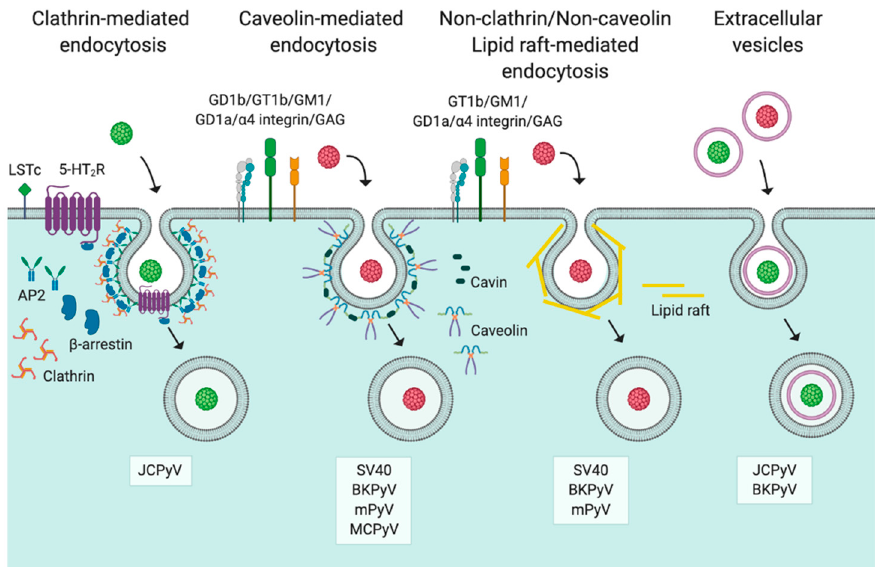
Figure 2. Entry pathways usurped by polyomaviruses. Polyomaviruses have been identified to hijack several of the currently known pathways to enter cells. JC polyomavirus (JCPyV) (green virion) is the only characterized polyomavirus to date that utilizes clathrin-mediated endocytosis, while SV40, BK polyomavirus (BKPyV), murine polyomavirus (mPyV), and Merkel cell polyomavirus (MCPyV) (red virion, collectively) usurp caveolin-mediated endocytosis and/or non-clathrin/non-caveolin lipid raft uptake mechanisms. JCPyV and BKPyV have also been affiliated with extracellular vesicles as a tactic for entry into target cells likely bypassing cellular attachment and entry factors. Figure created with BioRender.com.